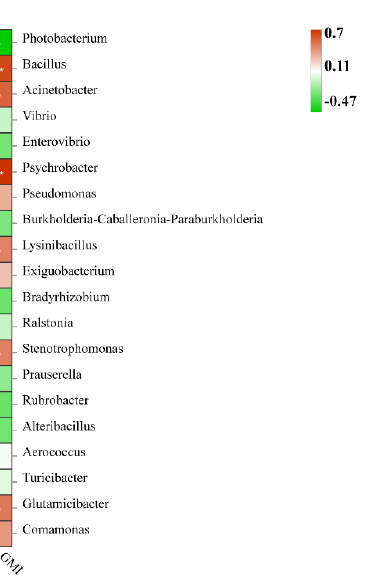
The level of GML addition showed a significant positive correlation with Acinetobacter , Acinetobacter , Stenotrophomonas , and Glutamicibacter ( p < 0.05), while a highly significant positive correlation was found with Bacillus and Psychrobacter ( p < 0.01). However, the addition of GML inhibited Photobacterium , with a significant negative correlation ( p < 0.05) (Figure 7).